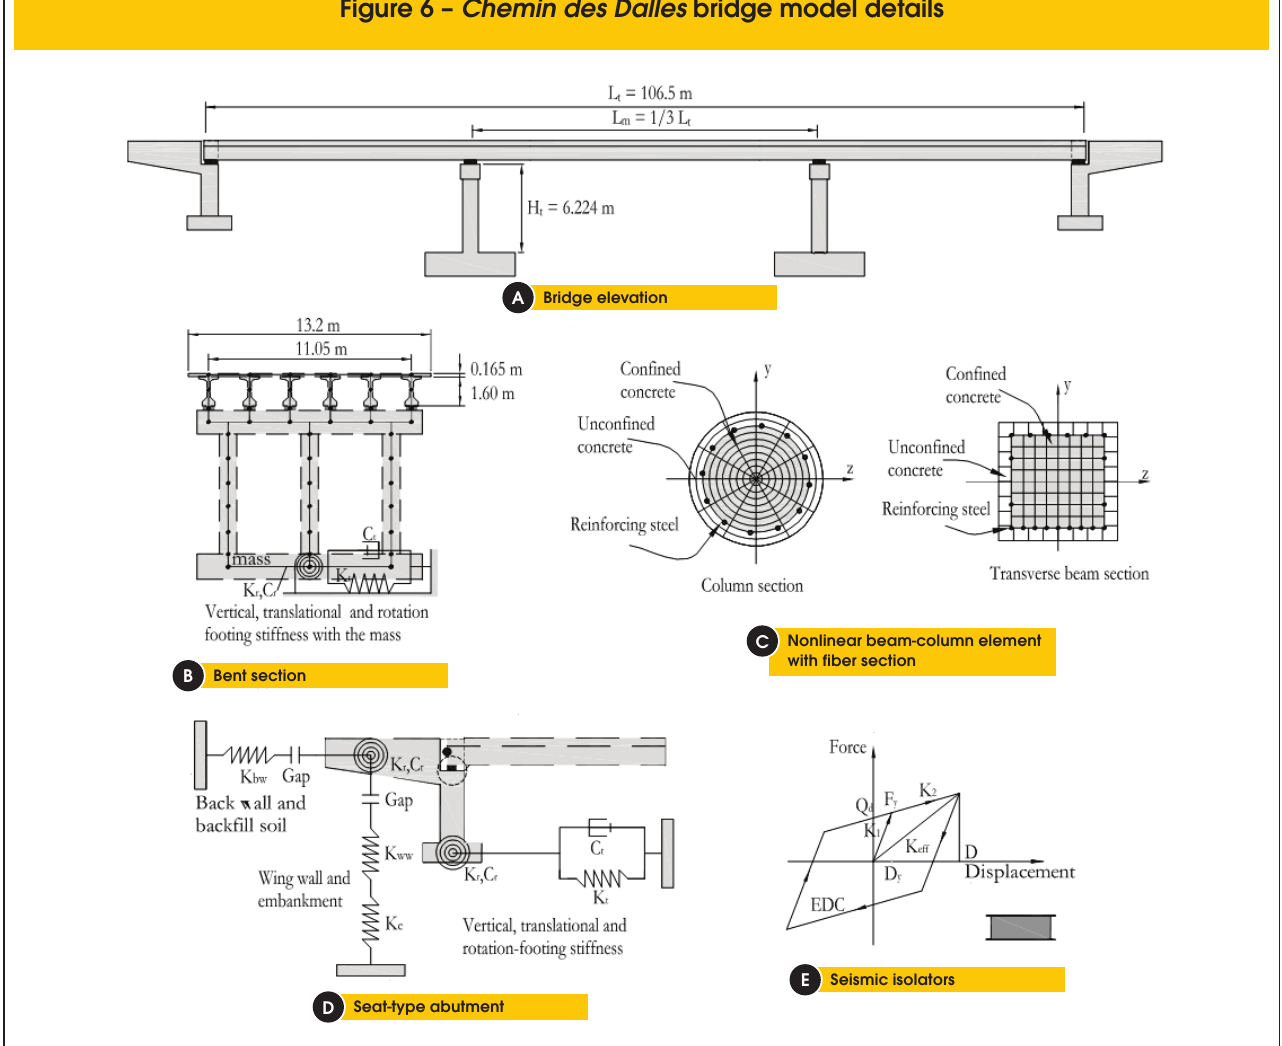
Figure 6 – Chemin des Dalles bridge model